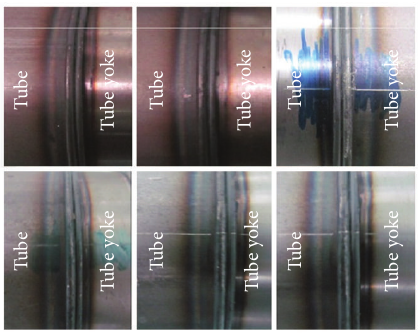
Figure 12: Undamaged welded joint areas after static torsion